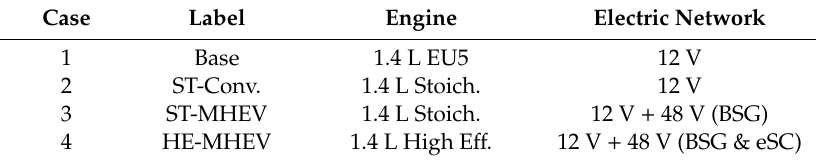
Table 3. Analyzed Powertrains Configurations. BSG: Belt Starter Generator; eSC: electric